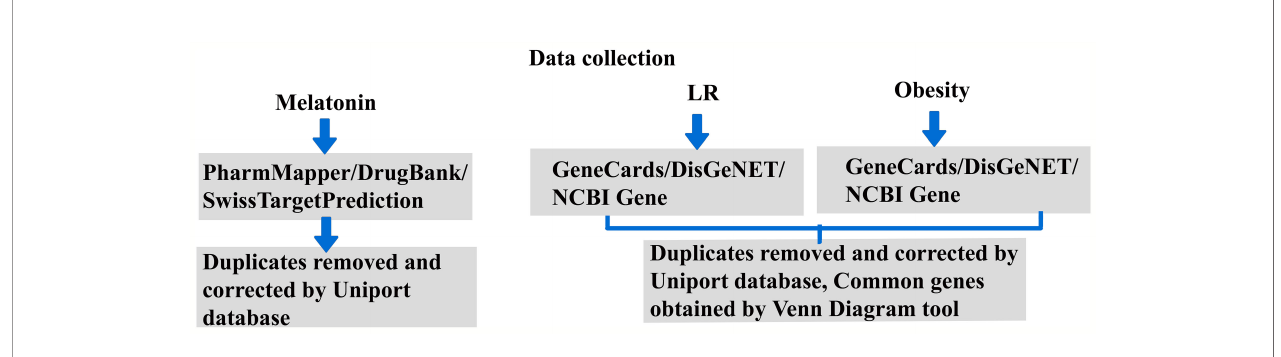
FIGURE 1 | Research Work